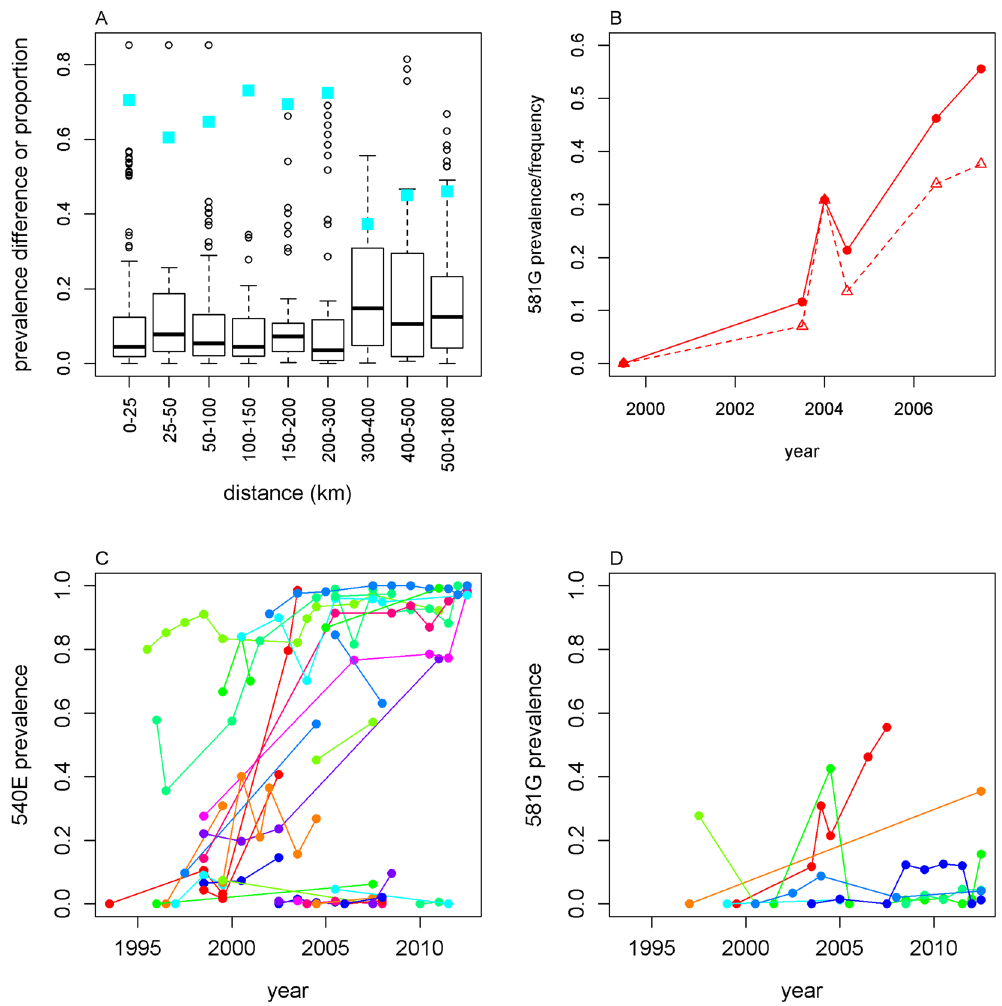
Figure 7. Spatiotemporal variation in 540E and 581G prevalence. ( A ) Different spatial scales. We compared prevalence of the same mutation in the same country between surveys done within 1 year of each other. We plot the pairwise distance between the surveys against the absolute difference in prevalence of the mutation. Blue squares indicate the proportion of survey pairs in which the difference in mutation prevalence was less than 10%. ( B ) Comparison of 581G frequency (triangles, dashed line) and prevalence (circles, solid line) in Tanga, Tanzania. Temporal trends in ( C ) 540E and ( D ) 581G prevalence. We compared successive measures within the same first administrative area which were < 100km apart. Supplementary Fig. S4 shows the same results for frequency measures. Comparisons of two zero prevalence measures are excluded in all